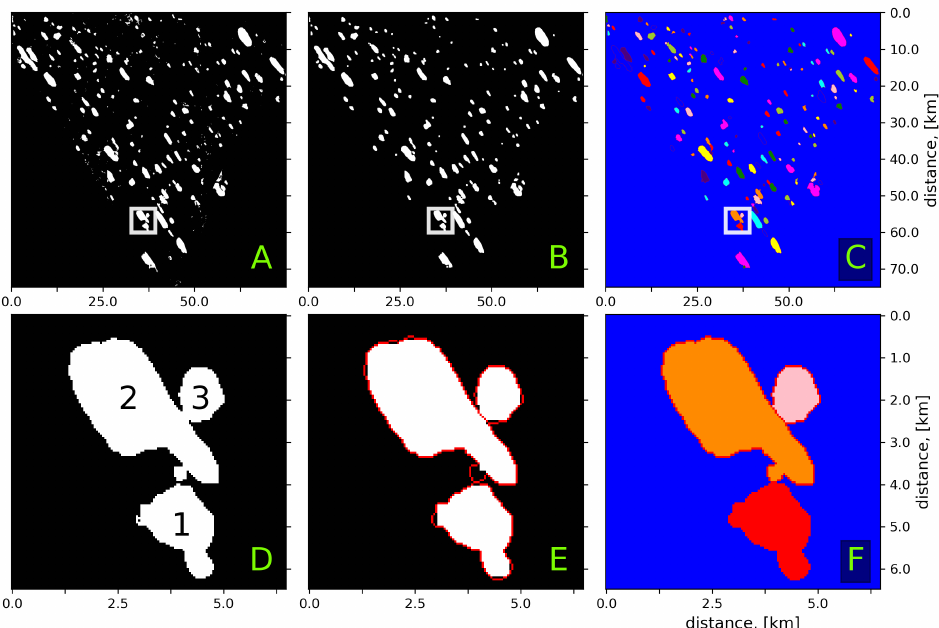
Figure 6. ( A ) segmented tundra lakes at Alaska test site (157.0301 ◦ W, 70.93083 ◦ N) from 20 October 2016 at 04:02:51, obtained by U-Net; ( B ) after filtering of small "noisy lakes"; followed by ( C ) instance segmentation, where white areas correspond to tundra lakes, and colored blobs stand for individual segmented lakes (instances). The white rectangles in ( A – C ) correspond to a zoomed area containing three lakes labeled as (1), (2) and (3); ( D ) raw U-Net output in the zoomed area, where lake 2 and lake 3 are overlapped (one instance); ( E ) lakes areas after morphological opening, and the obtained lake borders by the watershed segmentation, are indicated in red; ( F ) results of instance segmentation with the watershed algorithm, where each lake (instance) is depicted in different